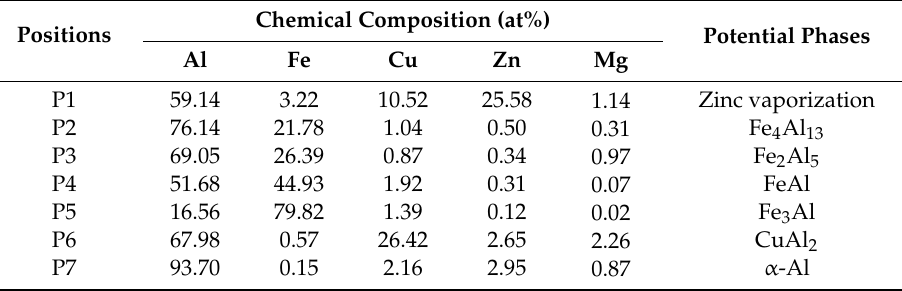
Figure 7. Micro-X-ray diffraction (XRD) analysis of the intermetallic compound (IMC) layer. Table 2. EDS results of the selected positions marked in Figure